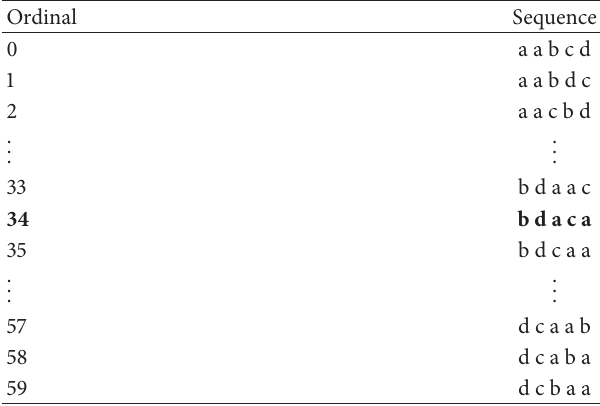
Table 1: Dictionary space and the position of the coded sequence. Ordinal